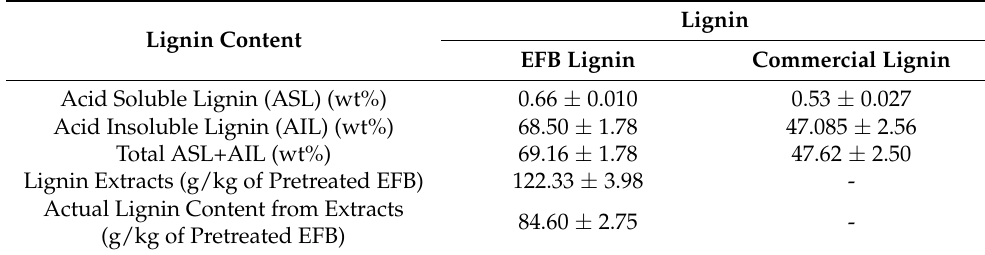
Table 3. Composition of extracted and commercial